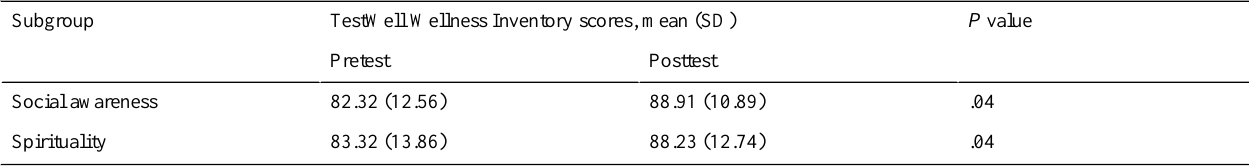
Table 1. Analysis of covariance of TestWell Wellness Inventory scores for each